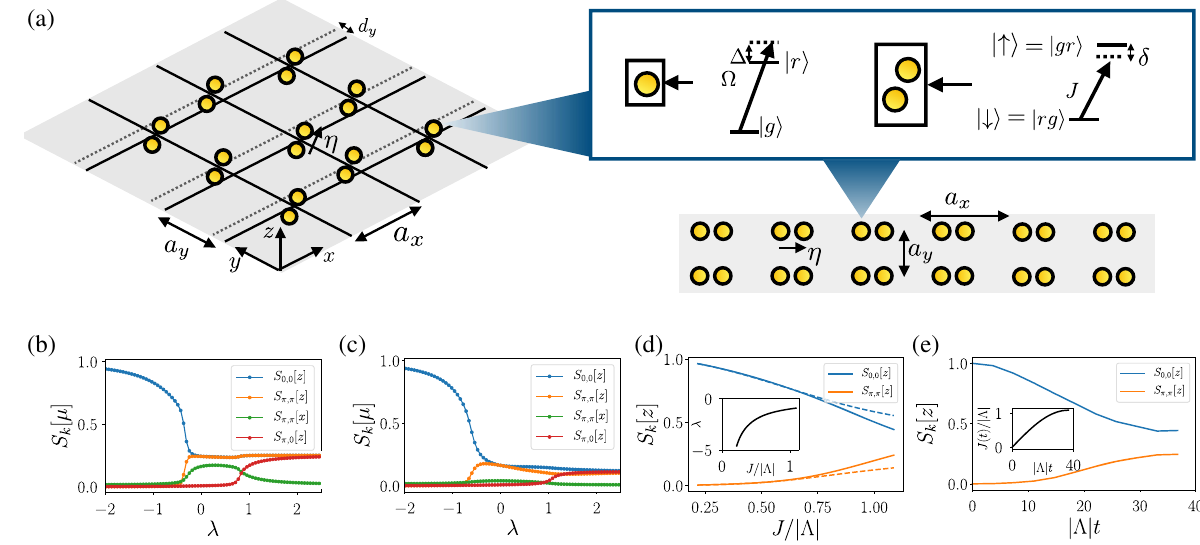
FIG. 4. RVBS in decorated Rydberg arrays. (a) Implementation of the RK Hamiltonian in decorated Rydberg arrays: Oriented pairs of close-by atoms with blue-detuned Rabi oscillations between the ground j g i and Rydberg j r i states are equivalent to oscillating spins 1 = 2 (see inset) with Ising interactions between them. By controlling the pair orientation relative to the lattice and the lattice geometry, we can engineer the spin-spin interactions such to achieve the generalized blockade conditions and realize the RK Hamiltonian in the dual formulation with a modified RK potential. We name such Hamiltonians as Rydberg-RK Hamiltonians. On the left we show the square lattice construction and on the bottom right the implementation for a ladder. The same principle applies to a generic 2D lattice. (b),(c) The phase diagrams of the Rydberg RK Hamiltonian on the square lattice (18) [ N ¼ 8 × 8 , (b)] and on the (periodic) ladder (15) [ N ¼ 32 × 2 , (c)] as a function of λ , calculated via DMRG. The two phase diagrams differ qualitatively from the ones of the original RK Hamiltonians shown in Figs. 3(b) and 3(c), respectively, for λ ≳ 1 . In particular, the ferromagnetic and the RVBS phases remain, while the columnar phase is substituted by a “ glassy ” phase. (d) In order to compare the phase diagrams of the effective RK Hamiltonian with the full spin description of the decorated Rydberg array, we compare the spin-spin correlations on a 6 × 2 decorated ladder, for j η j ¼ 0 . 38 a x and periodic boundary conditions, via exact diagonalization. The structure factors for the ground state of the effective RK Hamiltonian and the corresponding eigenstates of the Rydberg array Hamiltonian (up to next-nearest-neighbor interactions) are shown, ≈ 0 . 11 j Λ j within the atoms of each pair to select a respectively, as dashed and solid lines. We included a small detuning δ ¼ 0 . 1 C 6 =a 6 x specific ferromagnetic state as a reference. (e) Adiabatic preparation of the RVBS phase for the same parameters as (d). By smoothly ramping up the Rabi frequency J (inset), we can enter the RVBS phase within the validity of generalized blockade condition, J ≪ G